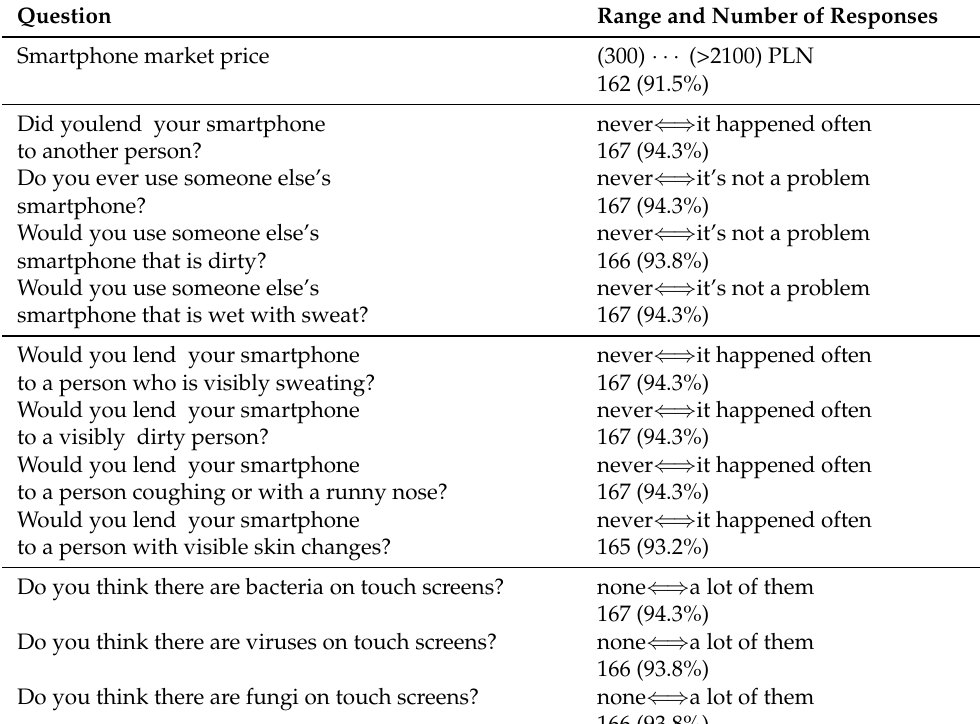
Table 1. Questions considered in this